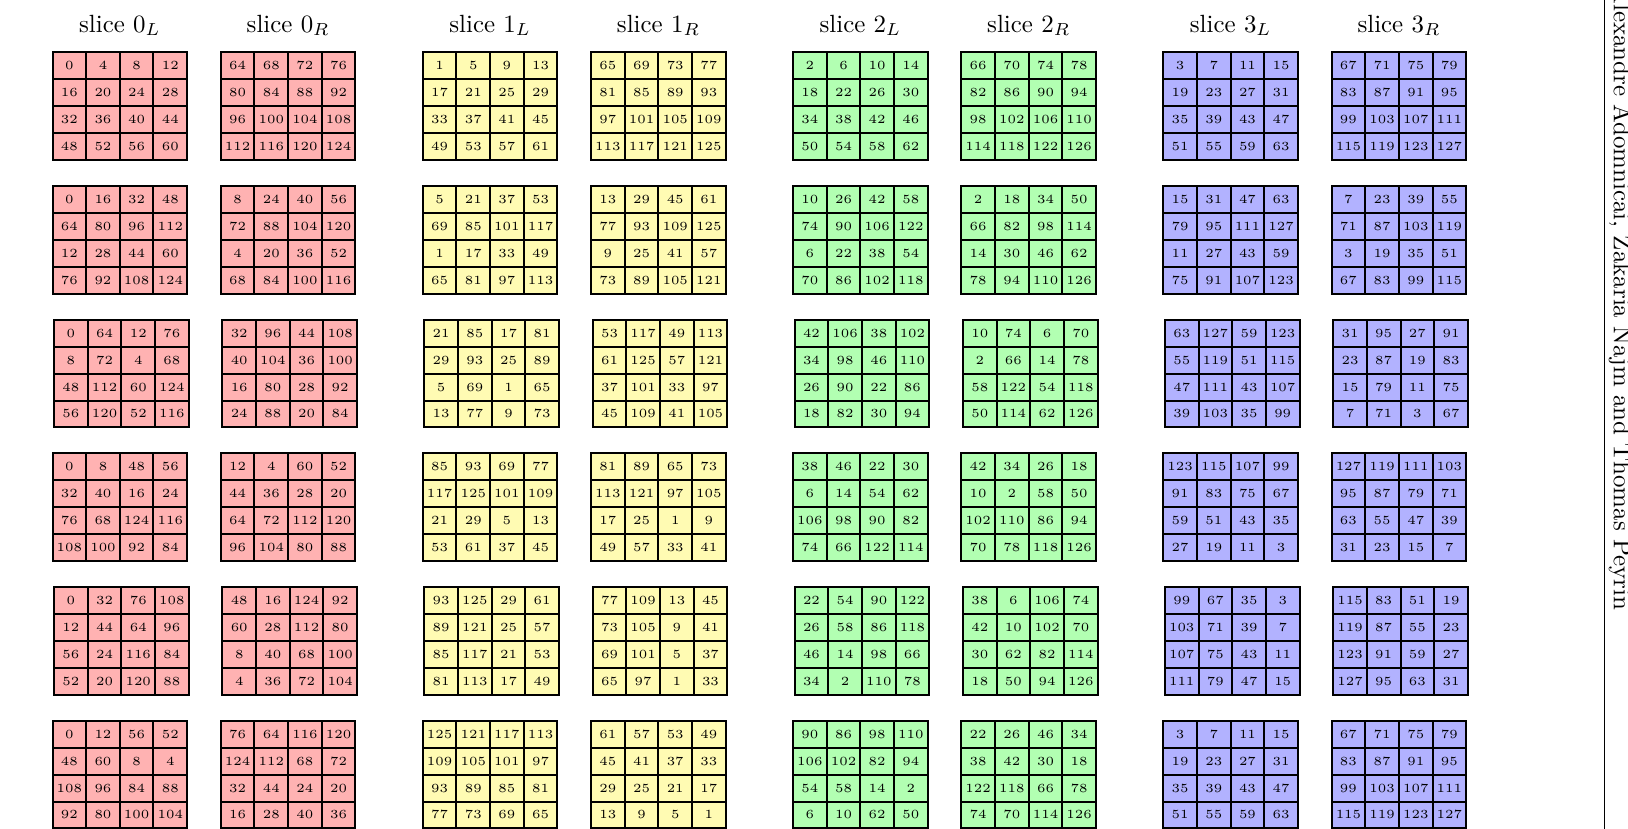
Figure 6: Classical representation of the GIFT-128 round function during 5 rounds. Each cell represents a bit, and the numbers in the cells then denote the actual index of that particular bit in the state. Slice 0 (resp. 1/2/3) depicted in red (resp. yellow/green/blue) represents all the bits at position 0 (resp. 1/2/3) of the S-boxes of the cipher